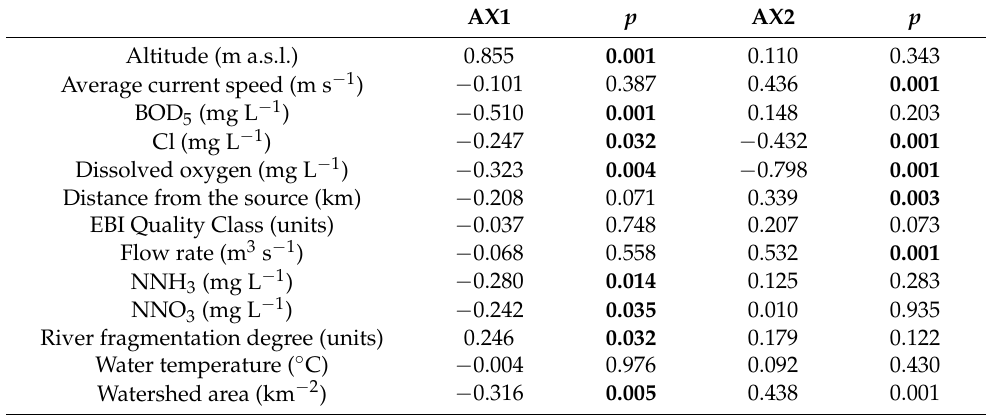
Table 1. Canonical and correlation coefficients of environmental variables with axis. p < 0.05 is in